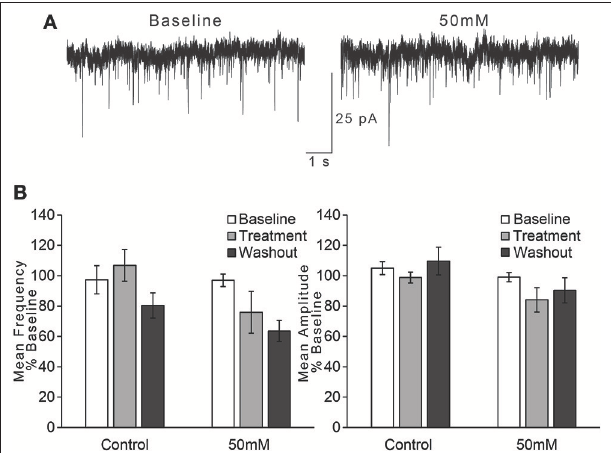
FIGURE 4 | Ethanol has no effect on spontaneous EPSCs in AIC layer 2/3 pyramidal neurons. (A) Representative traces from a single neuron showing spontaneous EPSCs (sEPSCs) before and after treatment with acute ethanol (50mM). (B) Summary charts showing mean frequency (left) and amplitude (right) of sEPSCs during the last 2min of each period of the experiment (Baseline, Treatment, and Washout), expressed as a percentage of the entire 10min baseline average. Values are expressed as averages ± S.E.M (Control, n = 8 neurons/8 slices/6 mice; 50mM, n = 9 neurons/9 slices/7 mice).